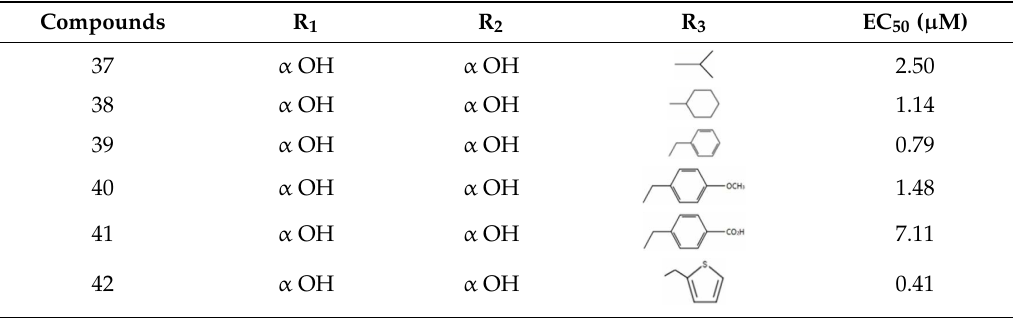
Figure 6. 2D image of the changes to bile acids sca ff old reported in Table 5. Table 5. Modifications made on bile acids sca ff